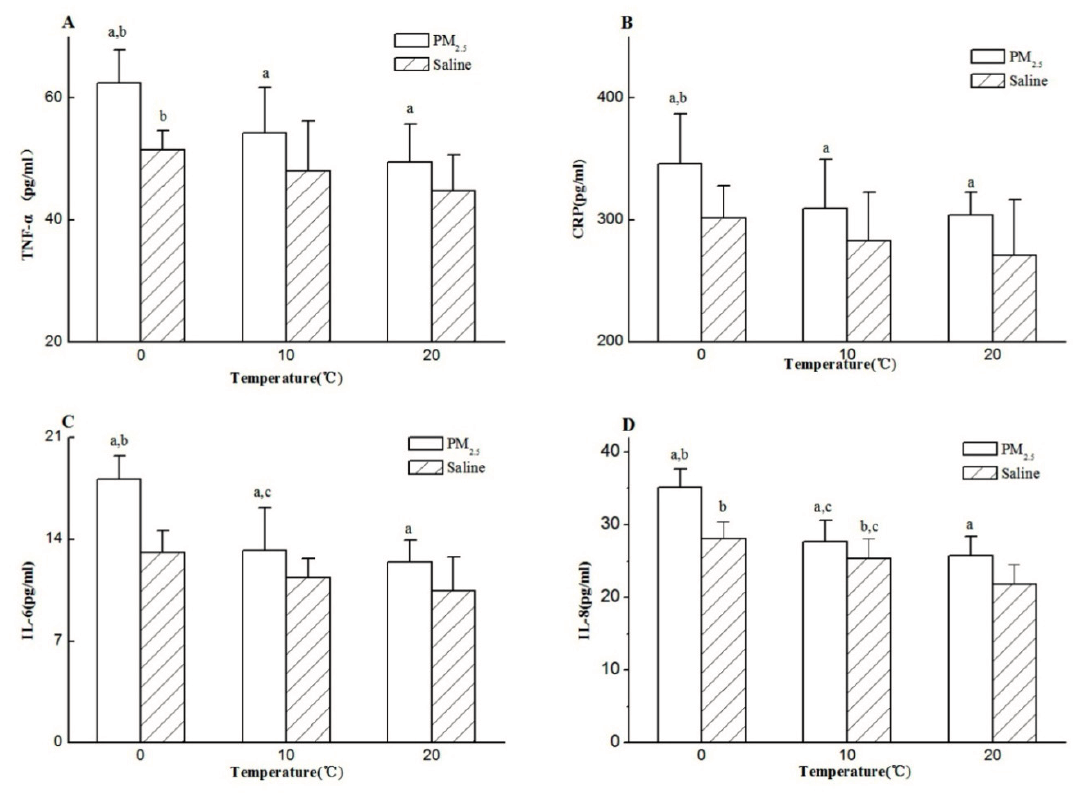
Figure 3. Inflammatory factors level in BALF. ( A ) TNF- ɑ , ( B ) CRP, ( C ) IL-6, ( D ) IL-8. (8 mg/rat). Data represent as the mean ± SD. n = 8/group, instillation of PM 2.5 Significance: a p < 0.05 compared to the corresponding cold stress alone group; b p < 0.05 compared to the normal temperature group with saline or PM ; c p < 0.05 compared to 2.5 0 °C group with saline or PM 2.5